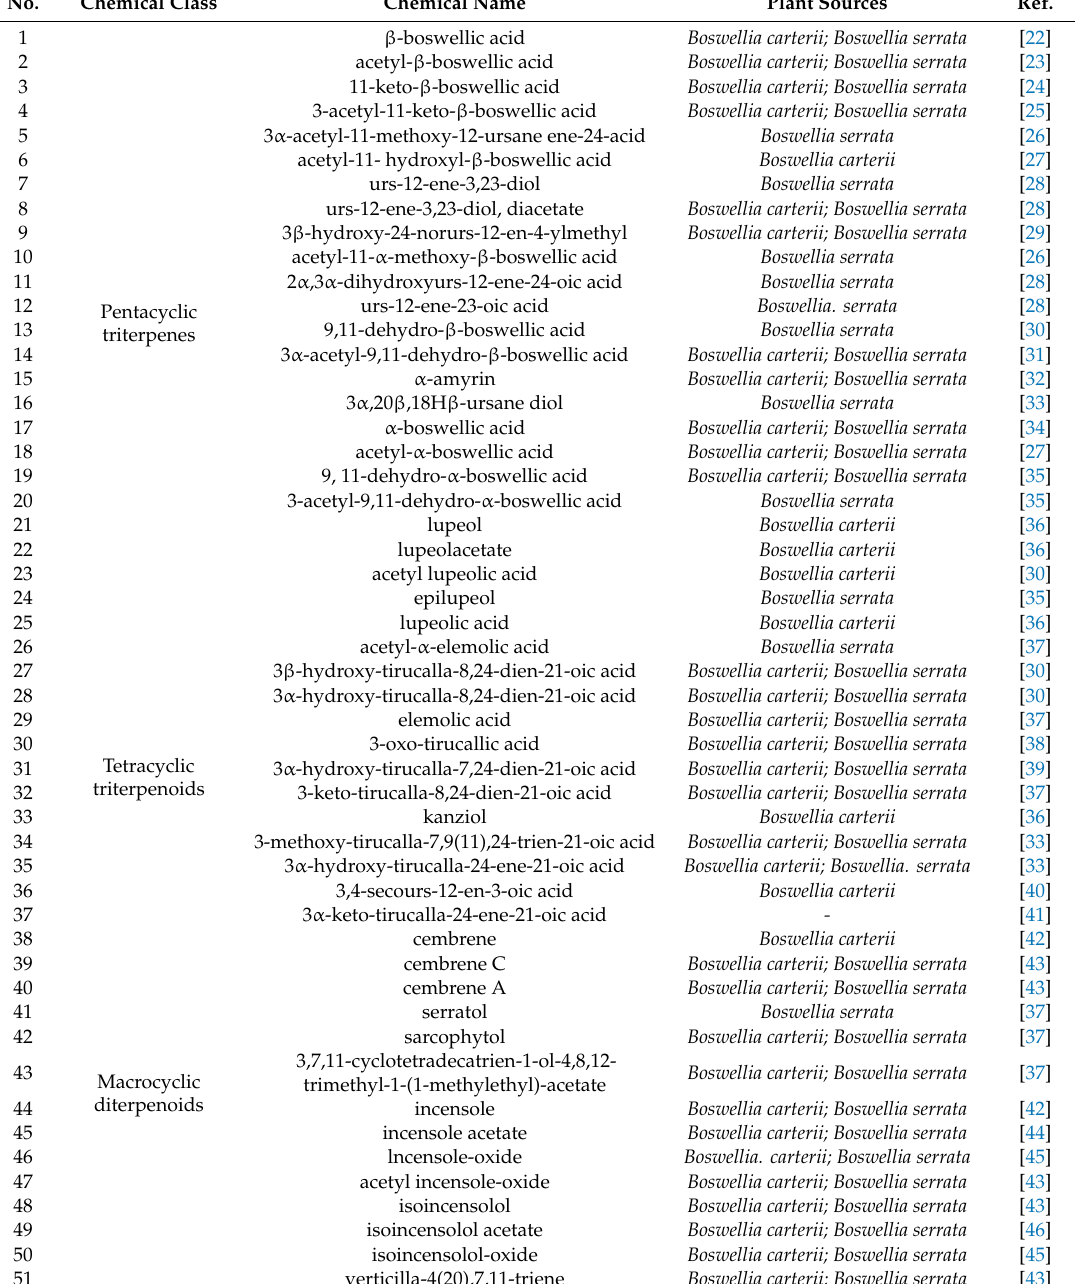
Table 1. Main chemical constituents and plant sources of